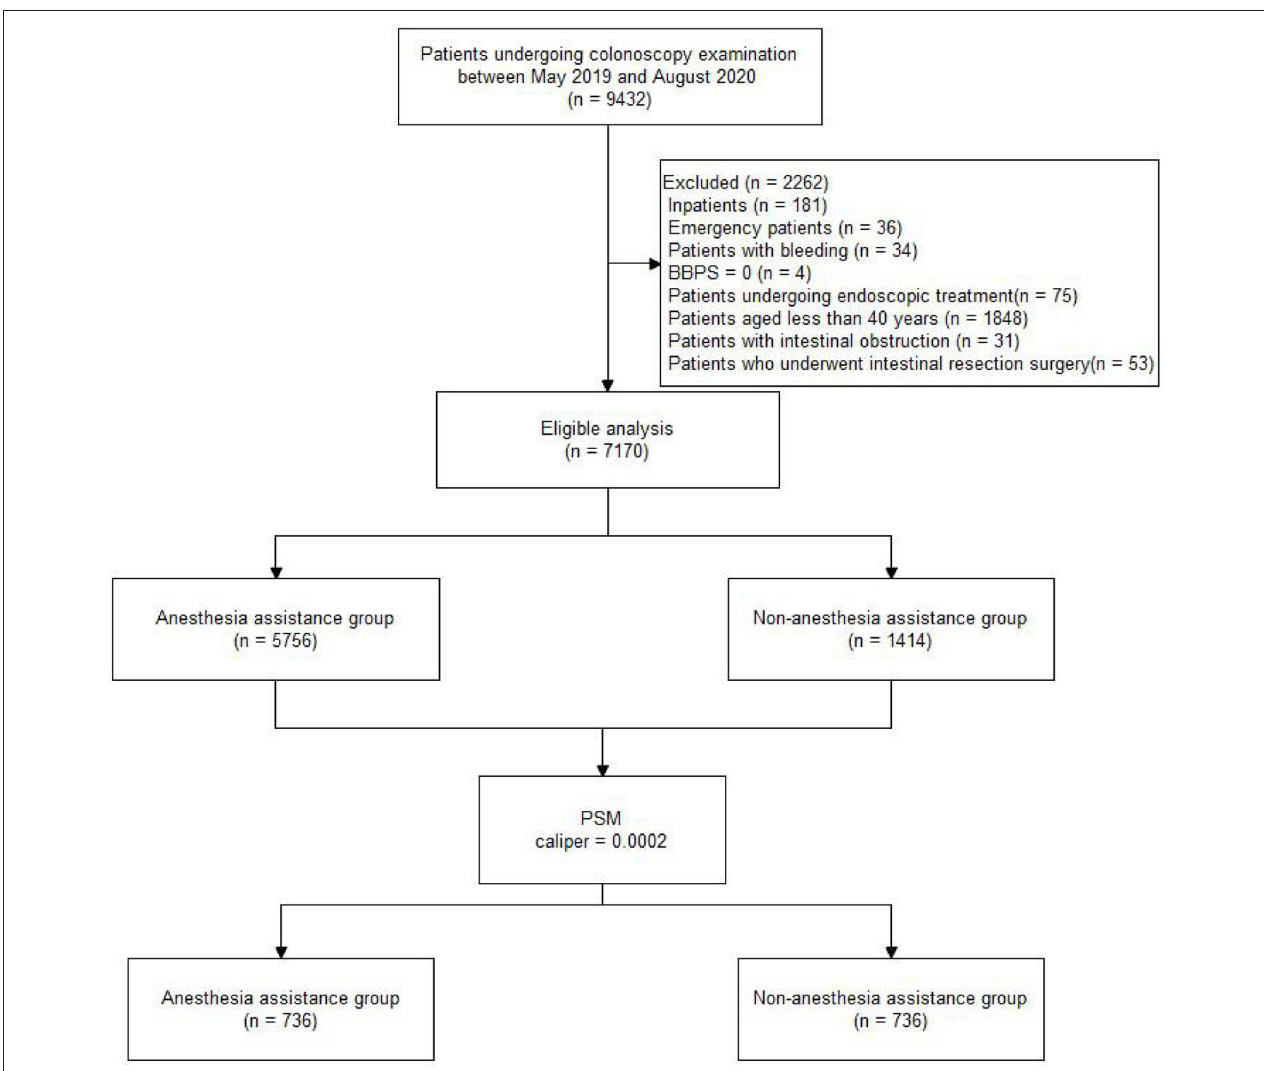
FIGURE 1 | Flow diagram of the study population. BBPS, Boston bowel preparation scale; PSM, Propensity score matching.